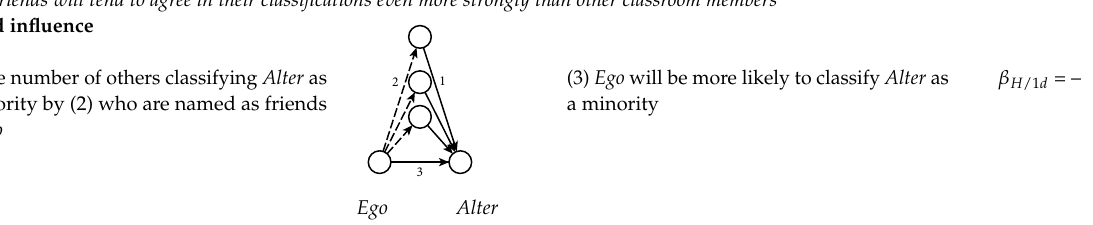
Solid black arrow: minority classification; white arrow: majority classification; dashed black arrow: friendship tie; black node: self-classified minority actor; white node: any